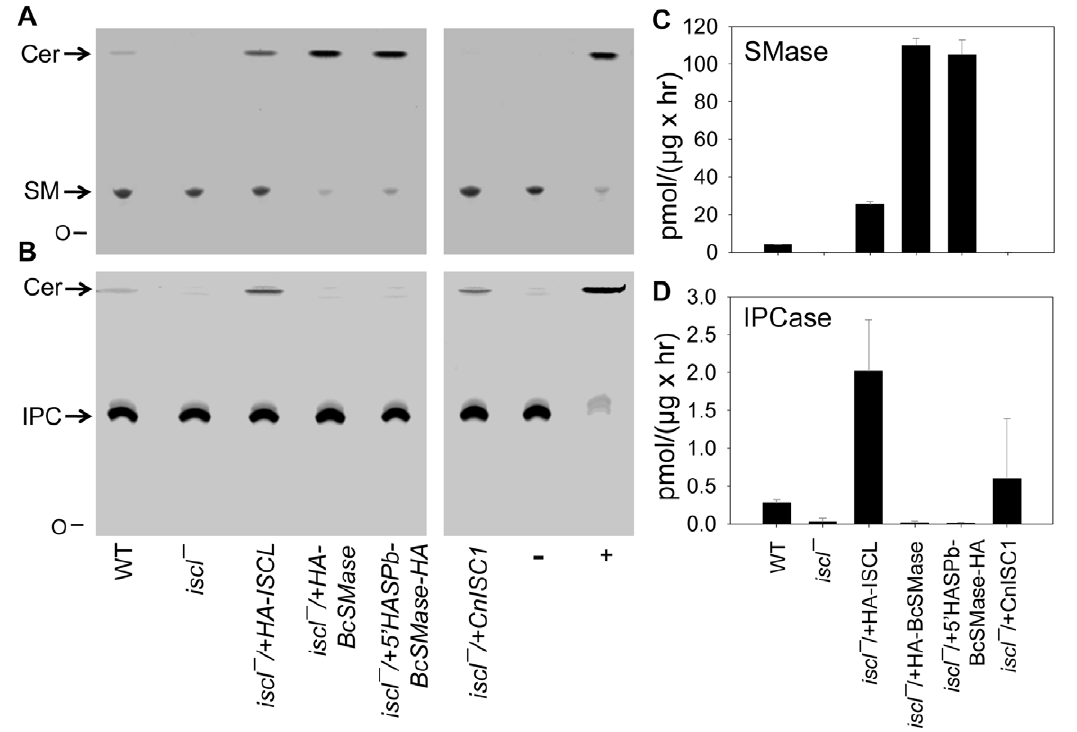
Figure 4. Introduction of a sole SMase or sole IPCase into iscl 2 . Whole cell lysates from late log phase promastigotes of WT, iscl 2 , iscl 2 / + HA- ISCL, iscl 2 / + HA-BcSMase, iscl 2 / + 5 9 HASPb-BcSMase-HA, and iscl 2 / + CnISC1 parasites were incubated with NBD-labeled SM ( A and C ) or NBD-labeled IPC ( B and D ) as described in Materials and Methods. Each reaction contained , 40 m g of total protein corresponding to 4 6 10 6 cells. ( A–B ) After incubation, lipids were extracted and separated by thin layer chromatography (TLC). Ceramide (Cer), a product of SMase and IPCase, migrates faster than sphingomyelin (SM in A ) or IPC ( B ). O: origin of migration. Positive control ( + ): 0.1 unit of purified Bc SMase ( A ) or 0.1 unit of purified Bc PI-PLC ( B ). Negative control ( 2 ): boiled WT lysate. ( C–D ) Activity of SMase ( C ) or IPCase ( D ) in Leishmania cell lysates was quantified after TLC analysis based on the amount ceramide produced and the amount of protein in each reaction. Error bars represent standard deviations from 3 independent